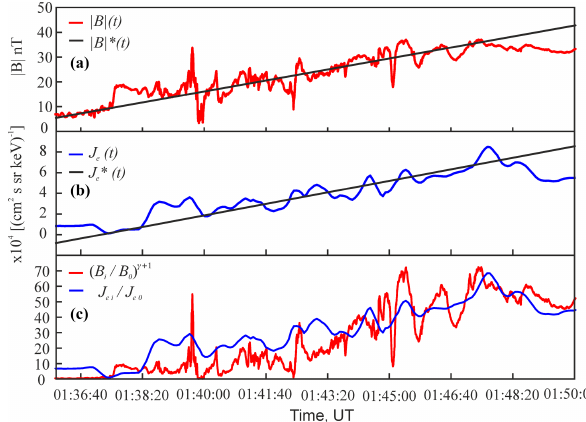
Figure 8. Panels (a–c) show the time profiles of the absolute value of the magnetic field | B | (t) and electron flux J e (t) at 50.5keV dis- played along with the linear approximations | B | ∗ (t) and J ∗ e (t) , re- spectively (for explanation, see Sect. 6). In (c) the time profiles of J ei (t)/J e1 and ( B i (t)/B 1 ) γ + 1 are shown (for explanation, see Sect.